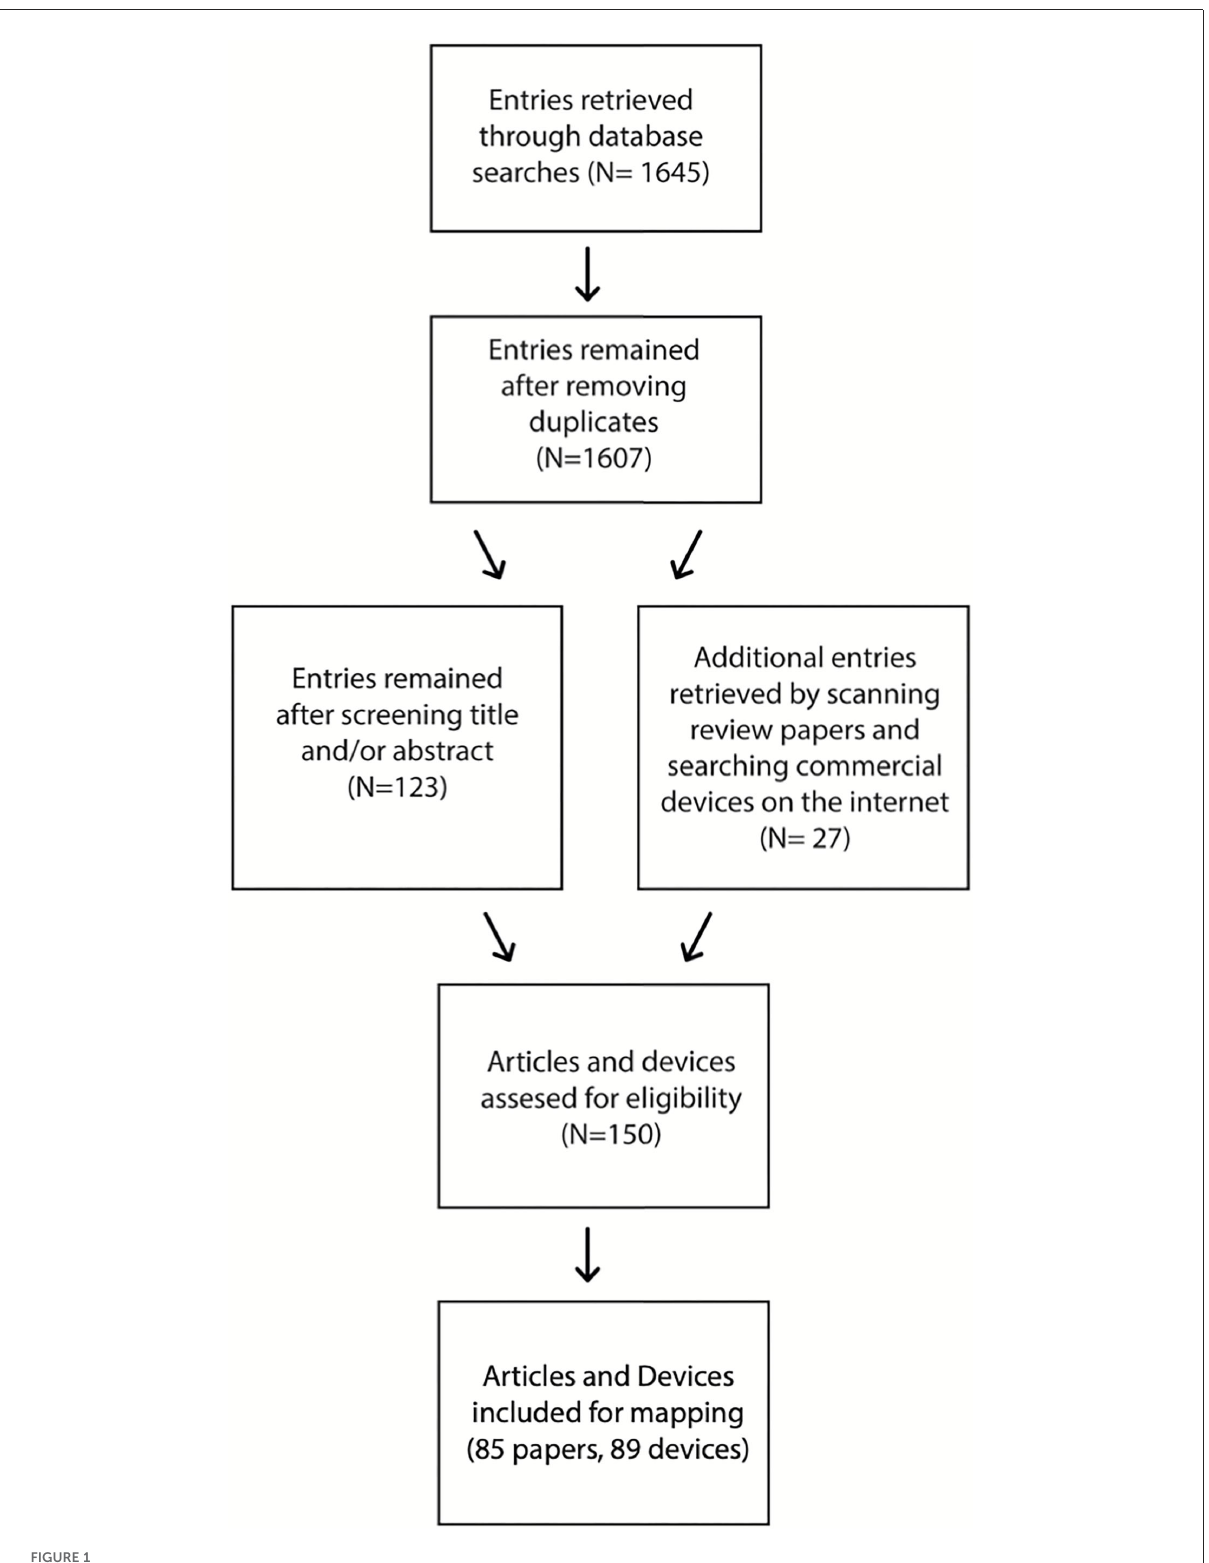
FIGURE1 Overview of the selection process for devices to be used for mapping the design space of